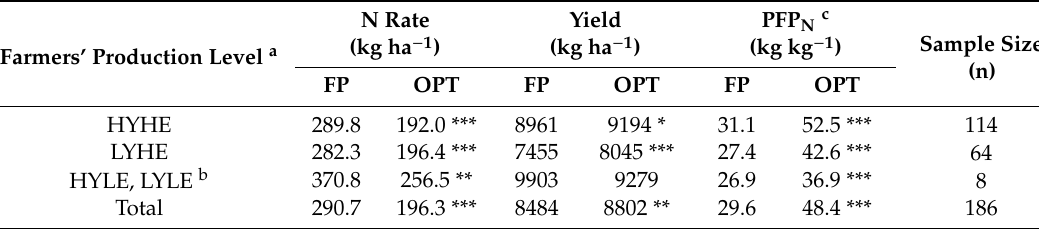
Table 3. Average N rate, rice yield and partial factor of applied N (PFP N ) under conventional (FP) and optimized N management (OPT) of farmers categorized according to productivity and nitrogen use e ffi ciency, based on data reported in the